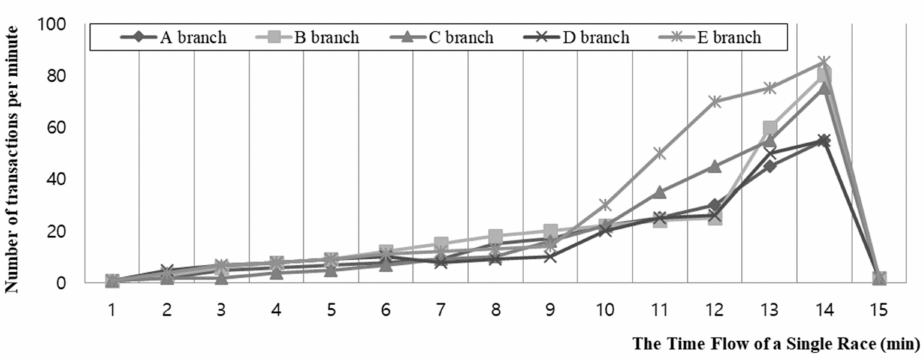
Figure 2. The average bets in a race that occurred in ten branches on the first Friday in January 2020.